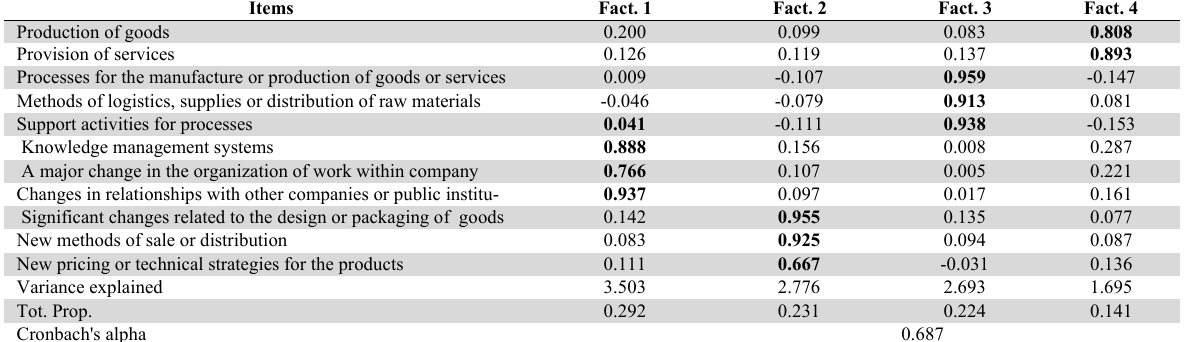
Principal component analysis of the variable relating to the types of innovation: Factor weights (Varimax Standardized) Items